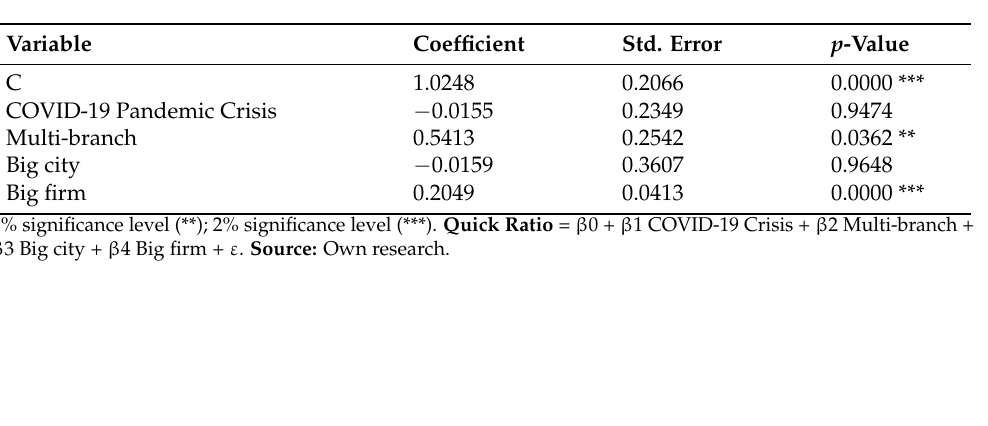
Table 3. The results of the second research